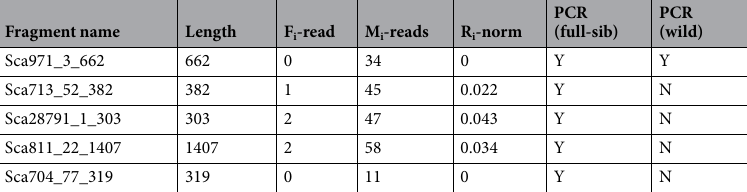
The detailed information is listed in Supplementary Table S2. PCR amplification was performed to test the accu- racy of our approach. Fragments were defined as Y-linked when a single, clear amplification product was detected in males, whereas no amplicons or only low-intensity bands of different sizes were observed in females. Full-sib PCR results showed that most fragments with R i -norm less than 0.15 were amplified only in males with an accu- racy of 94.12% (16/17) (Supplementary Table S2). Partial full-sib PCR results of representative sequences for the five scaffolds are shown in Table 3 and Fig. 3. Therefore, the five scaffolds were totally confirmed as Y-linked. The above results suggested that fragments with low R i -norm values tend to be Y chromosome sequences, and the fragment-ratio method is reliable for identifying Y-linked sequences in grass carp. PCR tests in wild population confirmed Y-specific sequences.